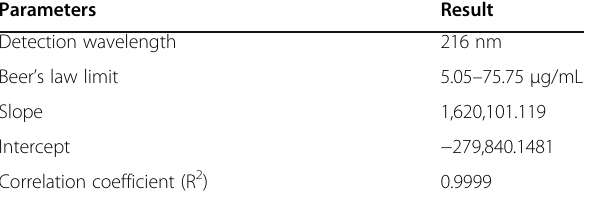
Table 14 Data for calibration curve of brexpiprazole